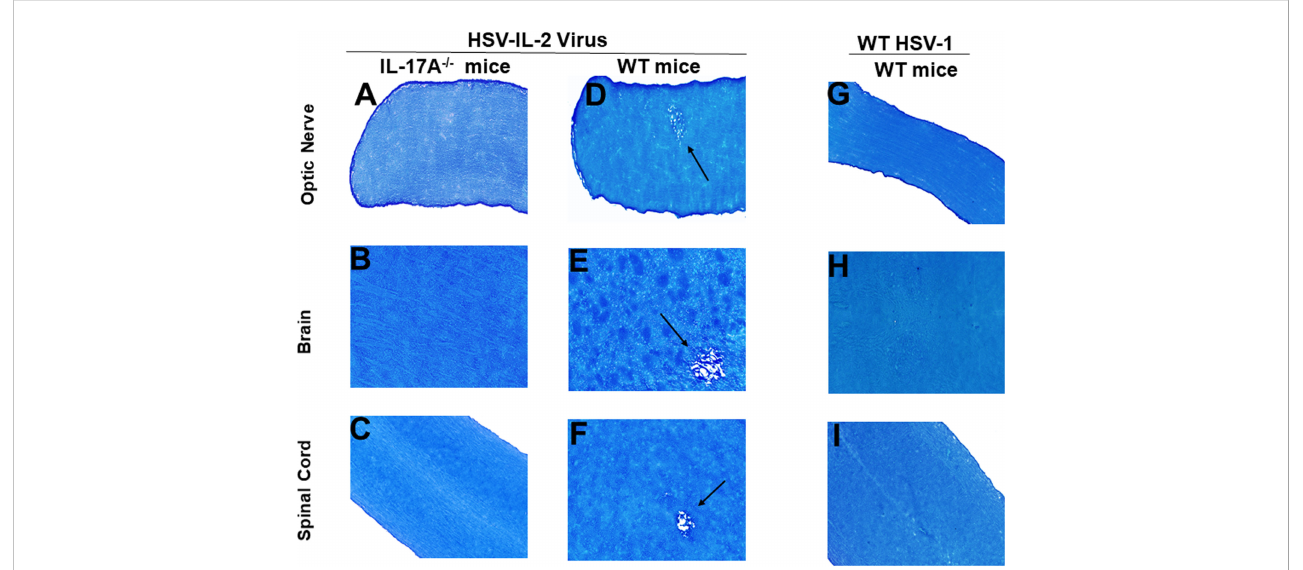
FIGURE 1 Role of IL-17A in HSV-IL-2 induced CNS demyelination. Five female IL-17A -/- (A – C) and WT C57BL/6 mice were infected ocularly with 2 X10 5 pfu/eye of HSV-IL-2 or WT virus as described in Materials and Methods. On day 14 PI, optic (A, D, G) nerves, brain (B, E, H) , and spinal cord (C, F, I) were collected, fi xed, sectioned, and stained with LFB. Representative photomicrographs are shown. Arrows indicate areas of demyelination. x10 objective lens was used (100x